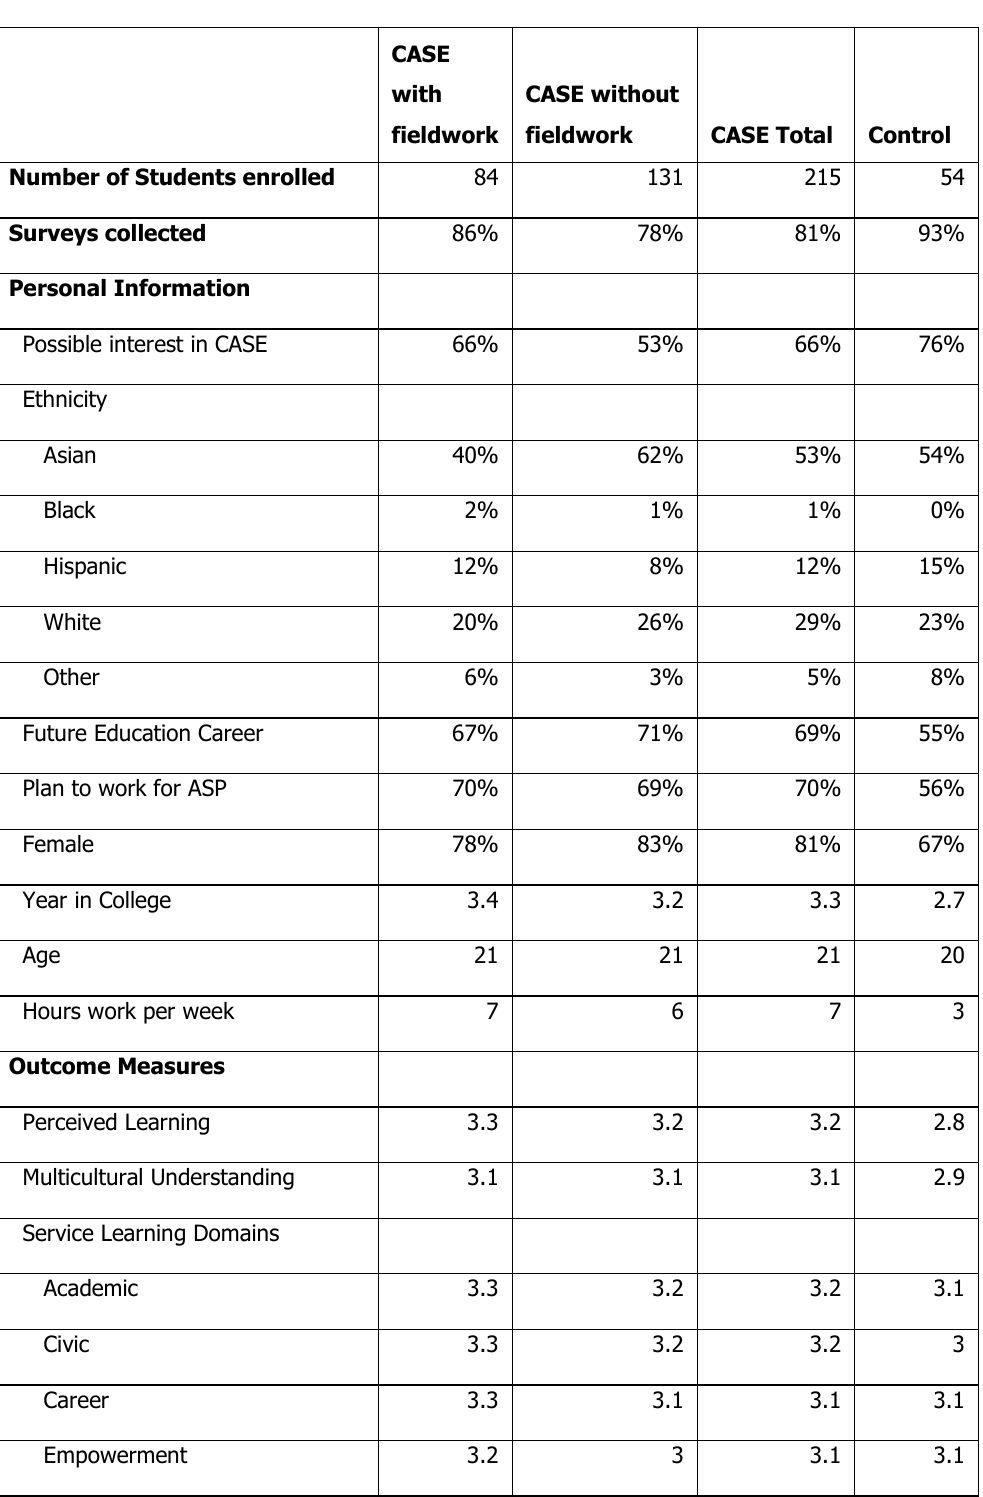
Descriptive statistics for study variables separately for students in CASE courses with and without field work and students in a control